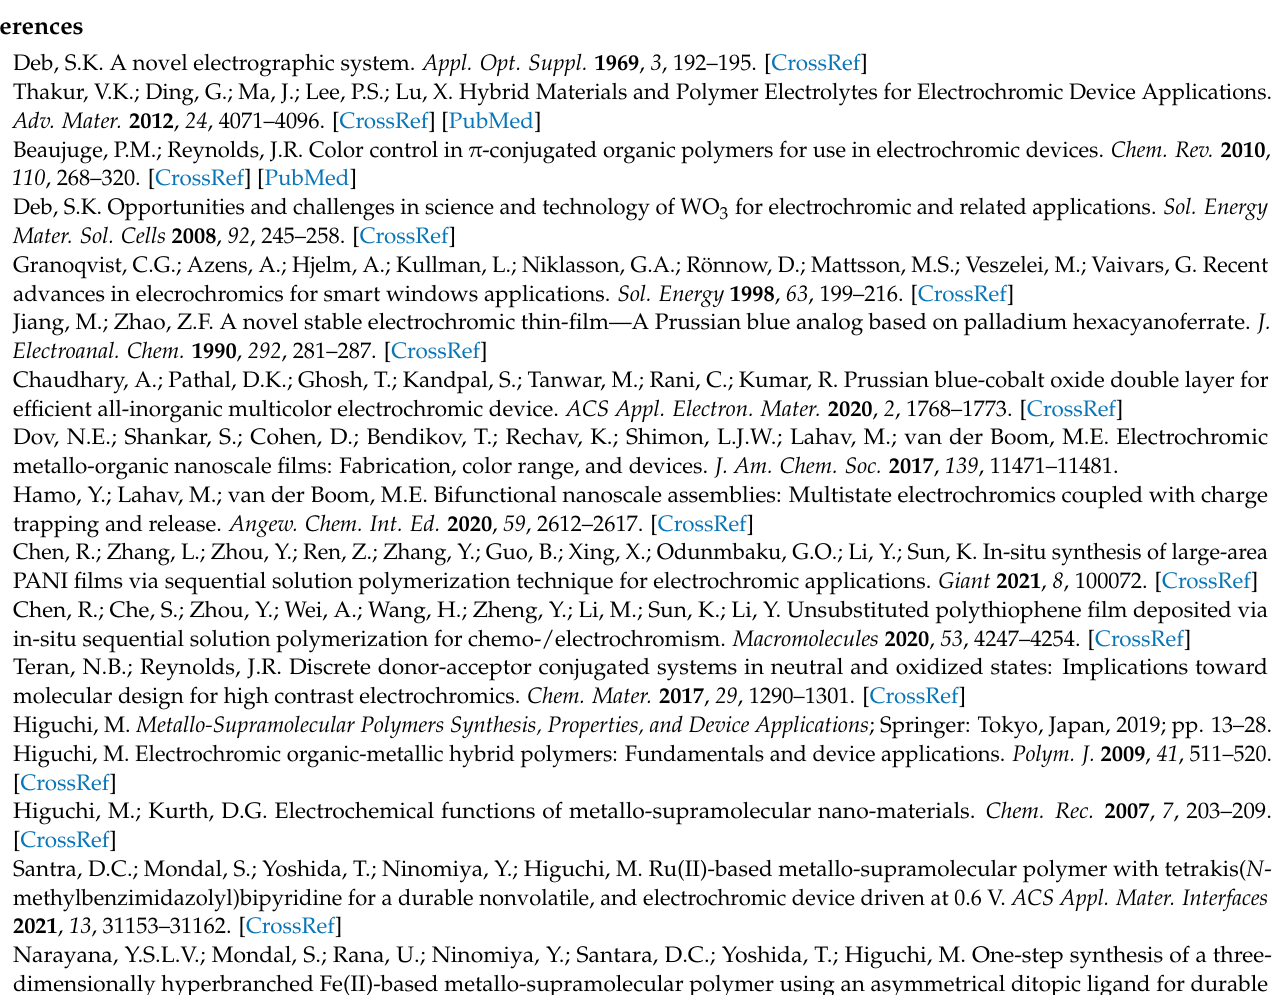
posites, Figure S4: SEM images and a histogram in particle sizes of polyFe/LIIm composite-3/1, Figure S5: CV